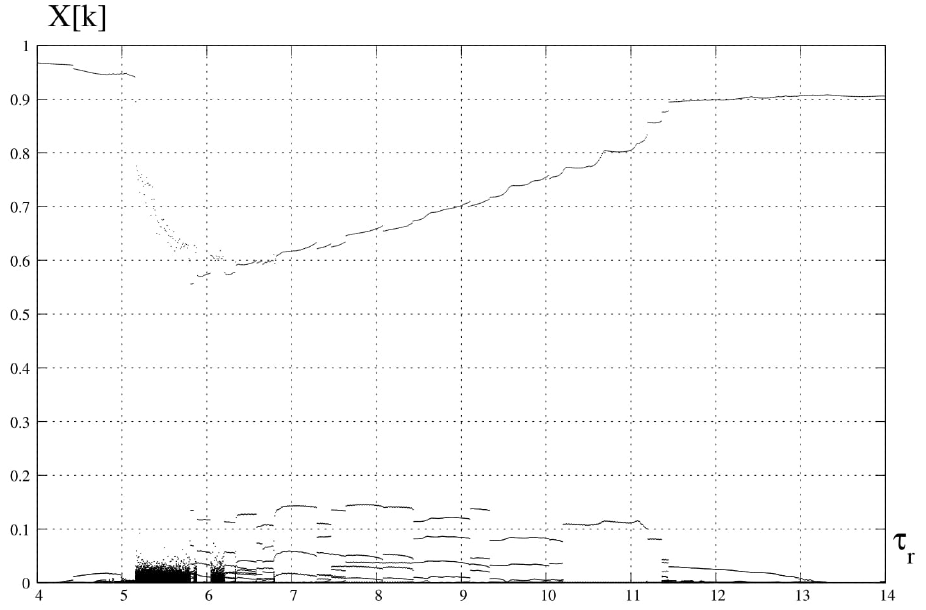
Figure 3. Diagram of the harmonics of the amplitude spectrum for Da = 0.13.